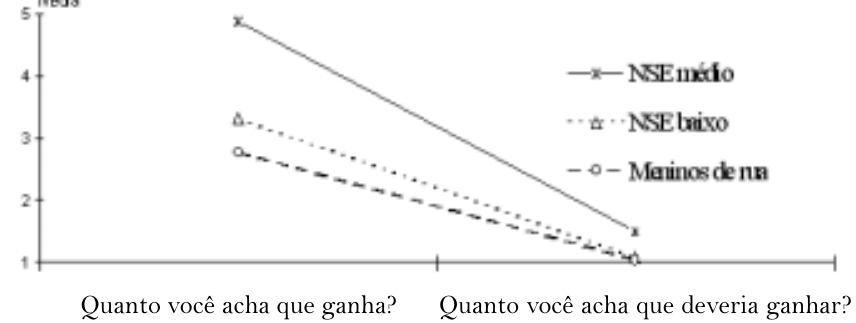
Figura 4 . Interação Grupo x Questão Acha/Deveria. VD: Razão das estimativas do nível